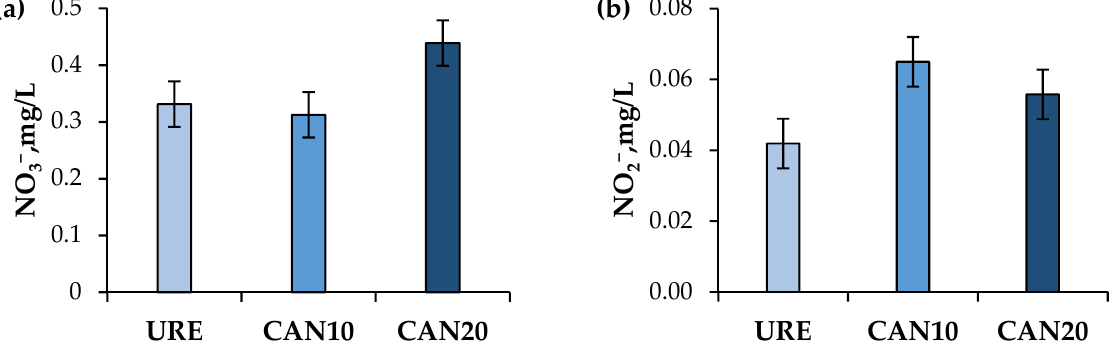
Figure 1. Effects of calcium-ammonium nitrate (CAN) fed to lactating dairy goats on ( a ) concentration of nitrate (NO 3 − ) in milk ( p -value: linear = 0.01; quadratic = 0.05; SEM = 0.042) and ( b ) concentration of nitrite (NO 2 − ) in milk ( p -value: linear = 0.11; quadratic = 0.04; SEM = 0.007). Dietary CAN did not affect the proportions of most saturated FA (SFA; 6:0, 8:0, 10:0, 13:0, 14:0, 15:0, 16:0, 18:0, 20:0) and monounsaturated FA (MUFA; 14:1, 15:1, 16:1, 17:1; Table 4). Additionally, there were no treatment effects on individual polyunsaturated FA (PUFA; trans -6 18:2, cis -6 18:2, cis -9- trans -11 CLA), while linear trends were observed for FA proportions of 11:0 ( p = 0.08) and 17:0 ( p = 0.09). The milk FA proportion of 12:0 was reduced ( p = 0.04; linear effect), whereas trans -9 18:1 ( p = 0.03) linearly increased. Total SFA, MUFA, and PUFA were not affected by CAN supplementation (Table 4).